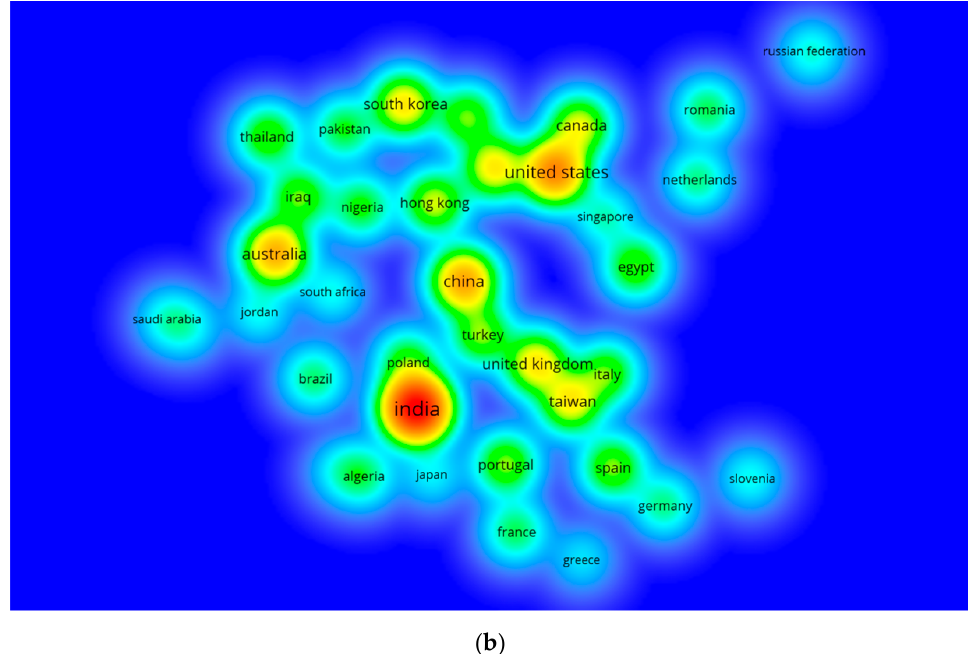
Figure 9. Countries mapping: ( a ) network visualization: ( b ) density visualization.